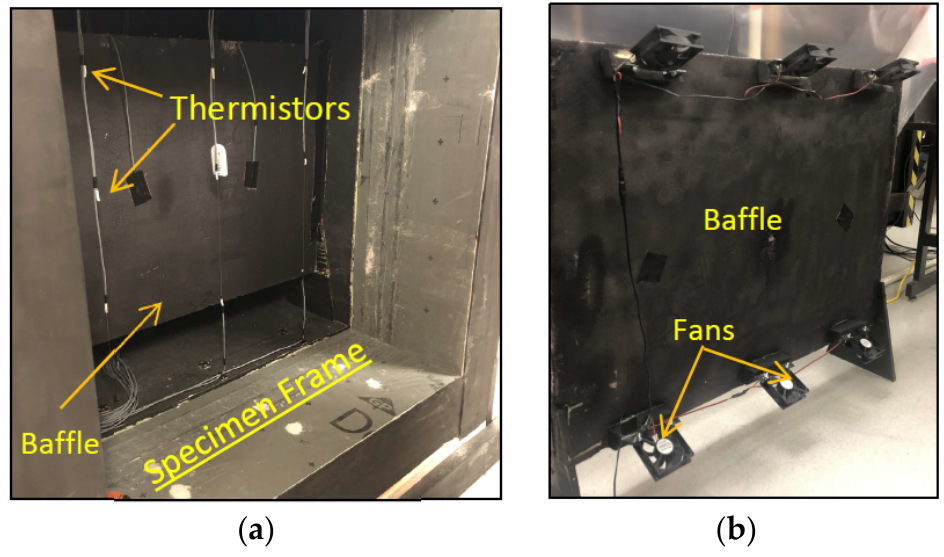
Figure 4. ( a ) Radiation baffle element; ( b ) fans attached to the baffle.